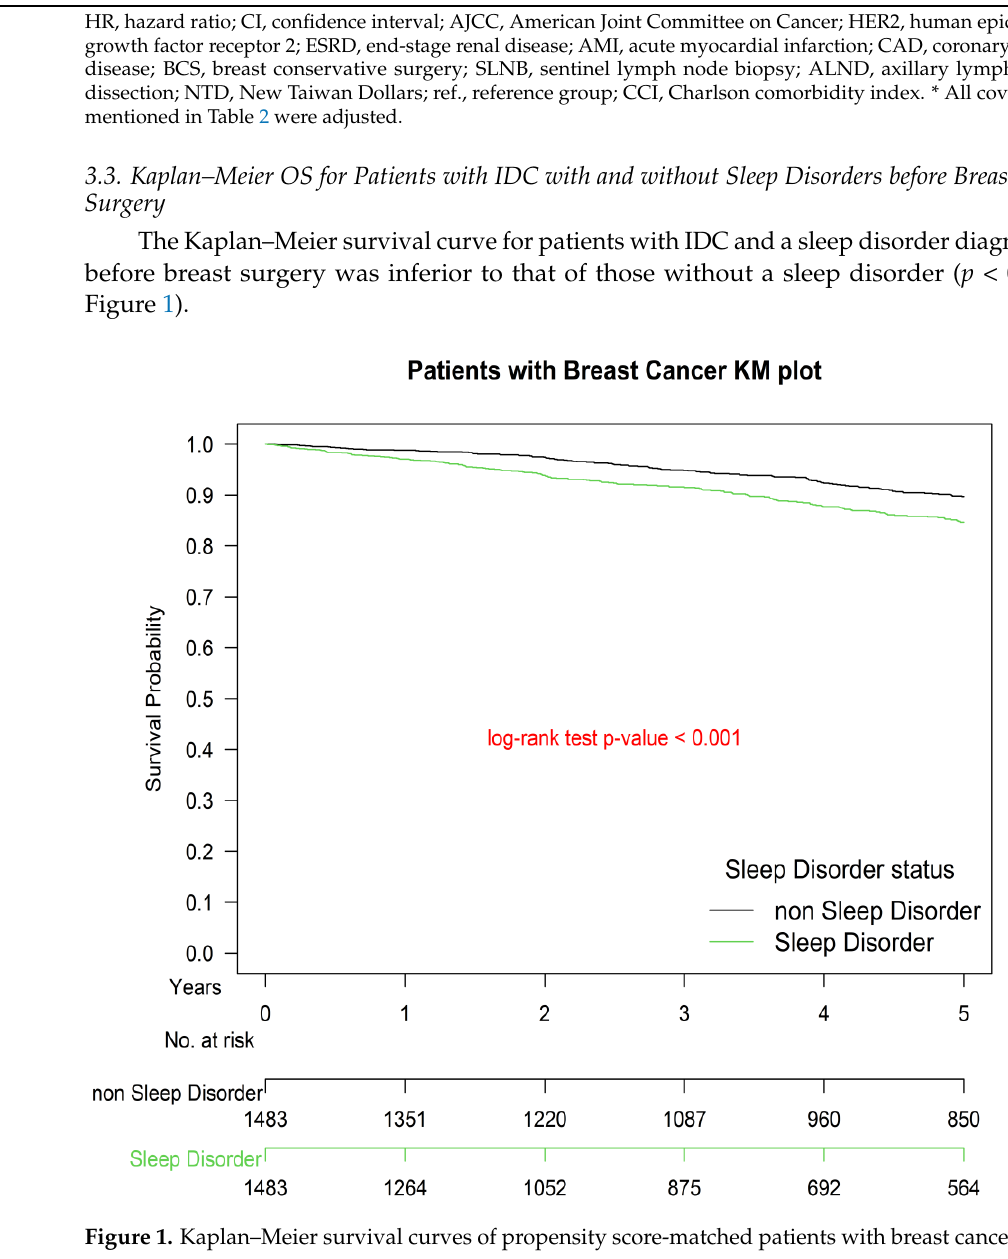
Figure 1. Kaplan – Meier survival curves of propensity score-matched patients with breast cancer with and without sleep